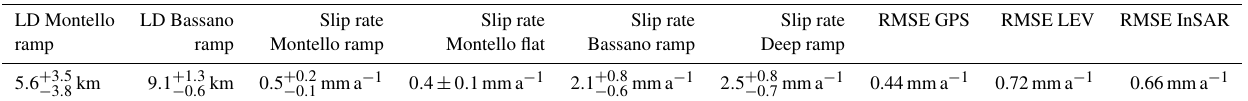
Table 2. Output model parameters (with 95 percentile confidence intervals) and data residuals in terms of root mean squared errors. LD Montello LD Bassano Slip rate Slip rate Slip rate Slip rate RMSE GPS ramp Montello ramp Montello flat Bassano